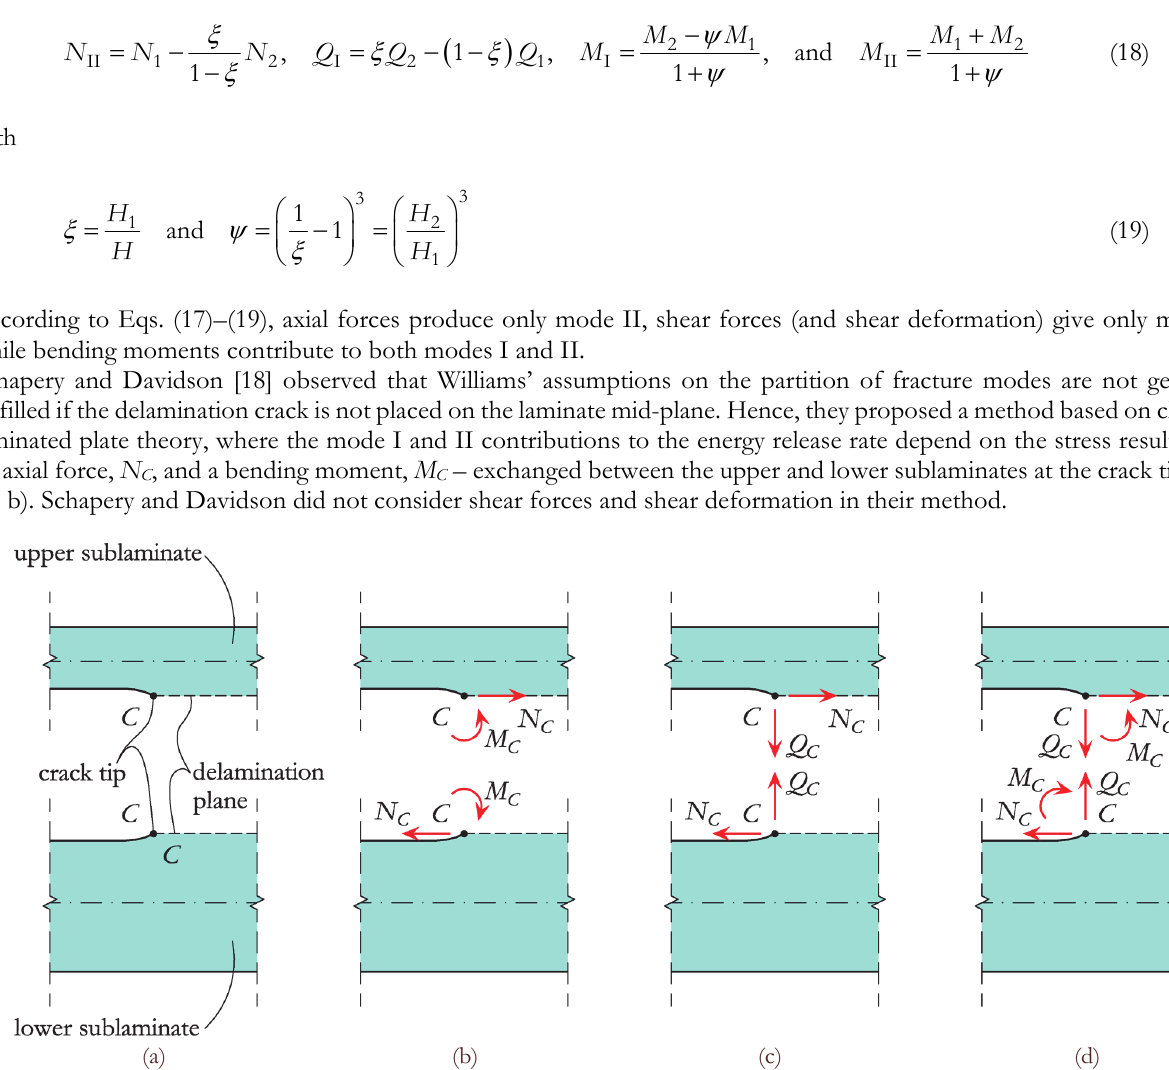
Figure 6: Crack-tip forces on (a) a split crack-tip segment, according to (b) Schapery and Davidson [18], (c) Wang and Qiao [20], and (d) Valvo